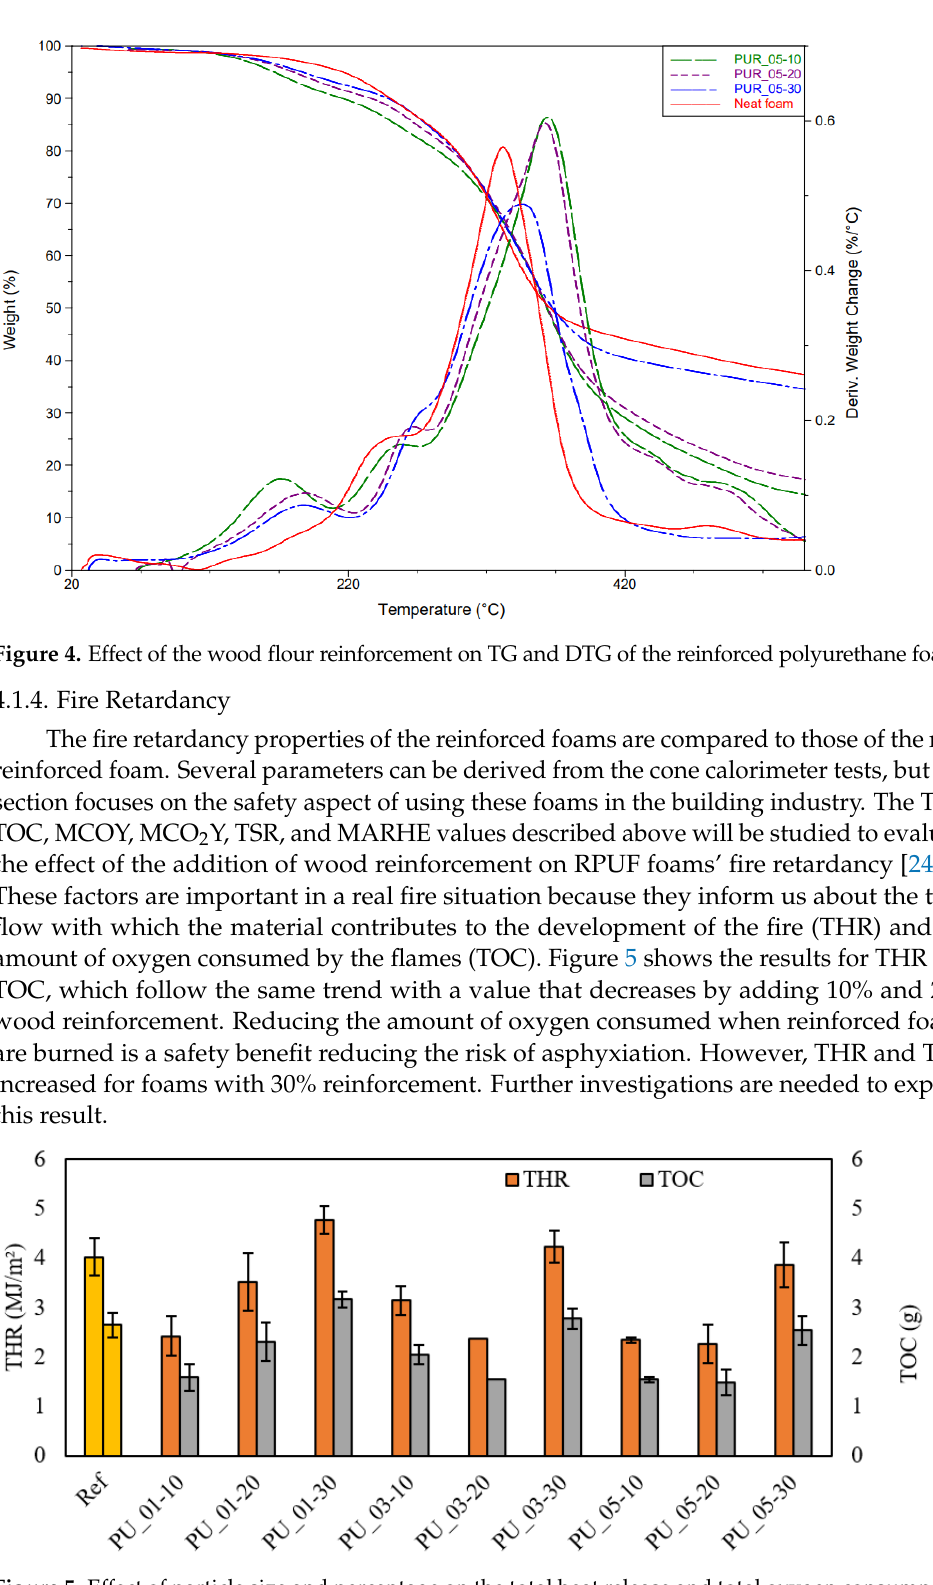
Figure 5. Effect of particle size and percentage on the total heat release and total oxygen consump- tion.